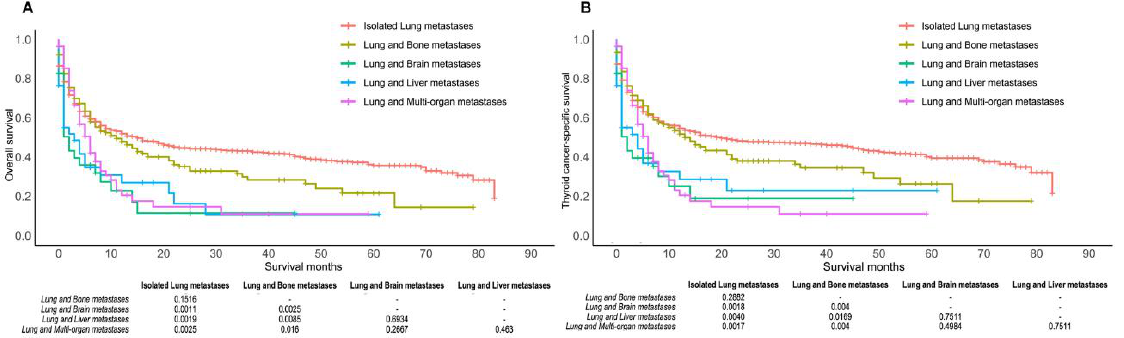
Figure 4. Kaplan – Meier curve of overall survival ( A ) and thyroid cancer-specific survival ( B ) ac- cording to the site of metastasis (isolated lung metastasis versus metastasis of ≥ 2 sites (including